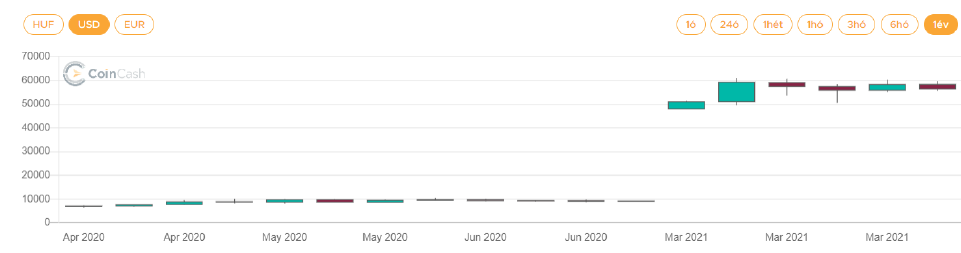
Figure 2. One-year Bitcoin rates in